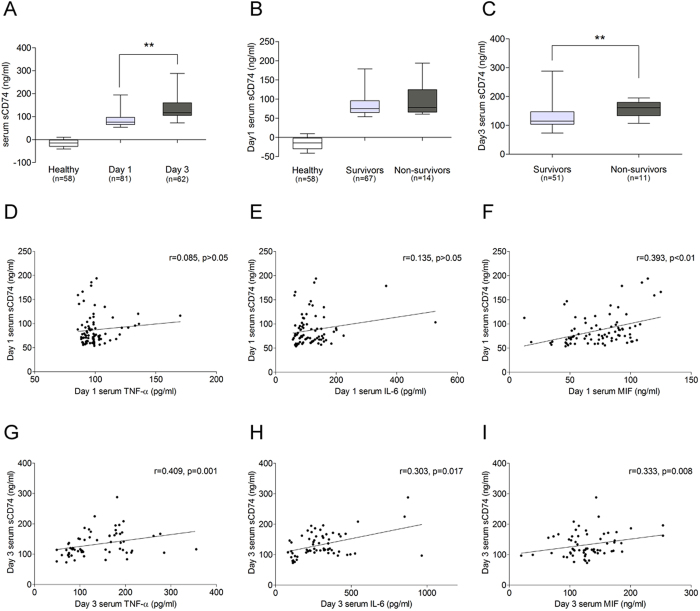
Serum sCD74 levels in ARDS patients.Serum sCD74 levels were measured in patients with ARDS (81 patients with Day 1 serum samples and 62 patients with Day 3 serum samples) as well as healthy volunteers (A). Data were presented as median (IQR), **p < 0.01 compared to control. Mann-Whitney U test was used to analyze difference of serum sCD74 levels between Day 1 and Day 3, and survivors and nonsurvivors. The increase in Day 1 and Day 3 serum sCD74 levels were compared to TNF-α (D,G), IL-6 (E,H) and MIF (F,I). Spearman rank correlation was used to analyze the relationship between sCD74 and TNF-α, IL-6 and MIF levels.